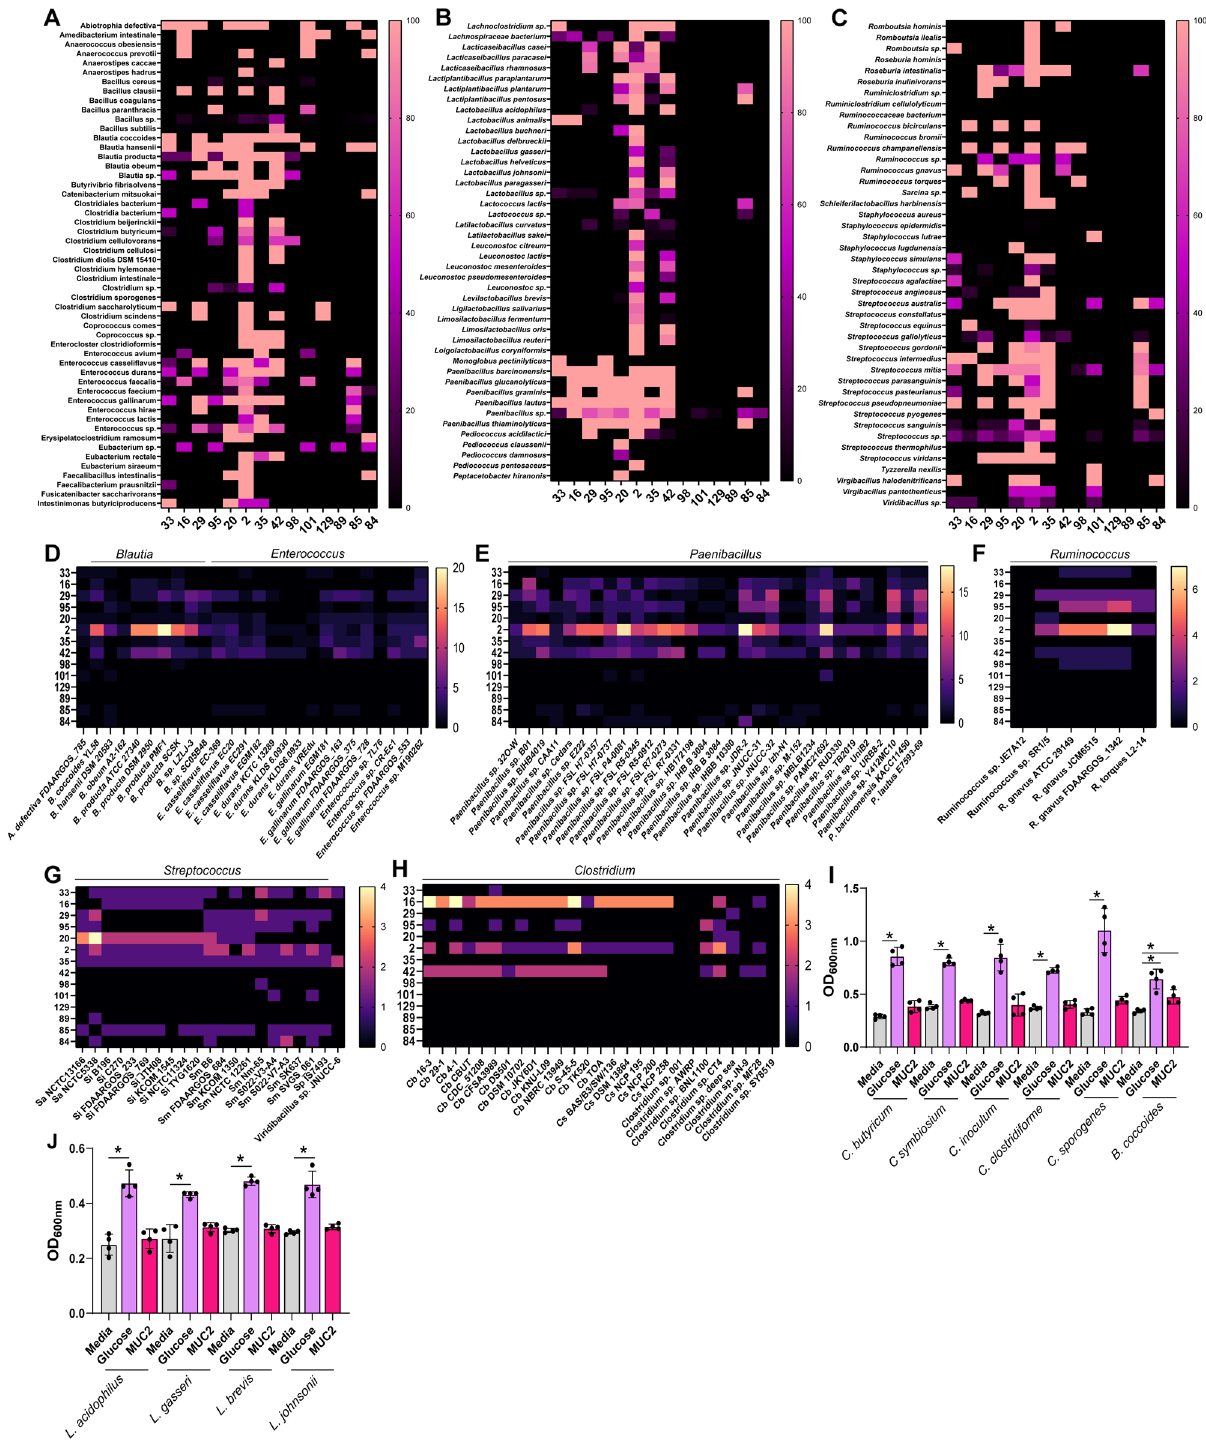
Figure 6. Mucin-related glycosyl hydrolase profiles in the Firmicutes phlyum. ( A – C ) Heat map of the Firmicutes genomes that have at least one gene copy of mucin-associated GH 33, 16, 29, 95, 20, 2, 35, 42, 98, 101, 129, 89, 85, and 84. Heat map showing the gene copy number of mucin-associated GHs in the strains of ( D ) Abiotrophia defective , Blautia coccoides, B. hansenii, B. obeum, B. producta, Blautia spp., Enterococcus casseliflavus, E. durans, E. gallinarum , and Enterococcus spp., ( E ) Paenibacillus, specifically Paenibacillus spp., P barcinonensis and P. lautus, ( D ) Ruminococcus, including Ruminococcus spp. R. gnavus and R. torques, ( F ) Streptococcus, including S. australis (Sa), S. intermedius (Si), S. mitis (Sm), Streptococcus spp. and Viridibacillus spp. ( G ) Clostridium, including C. butyricum (Cb), C. sporogenes ( Cs), and Clostridium spp. ( H , I ) Growth analysis of Clostridium butyricum CB, Clostridium symbiosum ATCC 14940, Clostridium inoculum ATCC 14501, Clostridium clostridiforme ATCC 25532, and Clostridium sporogenes DSMZ 795 ( H ), as well as Lactobacillus gasseri ATCC 33323, L. johnsonii ATCC 33200, L. brevis ATCC 27305, L. acidophilus ATCC 4796 ( I ) in a chemically defined media ZMB1 lacking glucose (media control), with glucose (positive control), or lacking glucose and supplemented with 1 mg/ mL porcine intestinal MUC2. Growth was measured by examining the optical density at 600 nm (OD 600nm ) after overnight